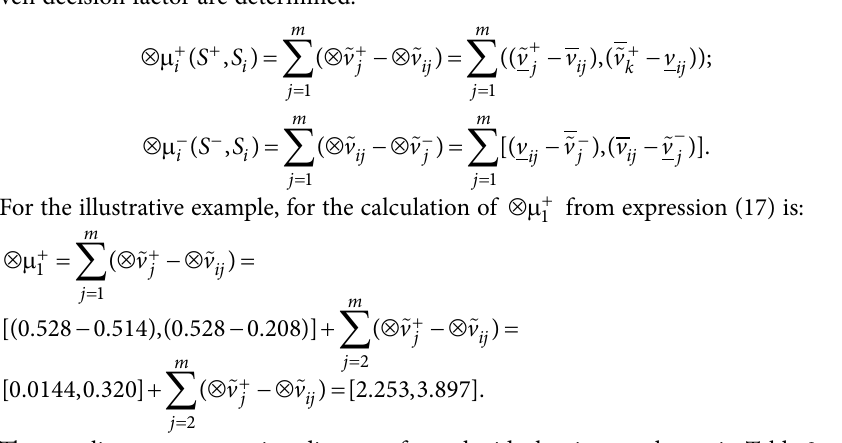
The suppliers grey separation distances from the ideal point are shown in Table